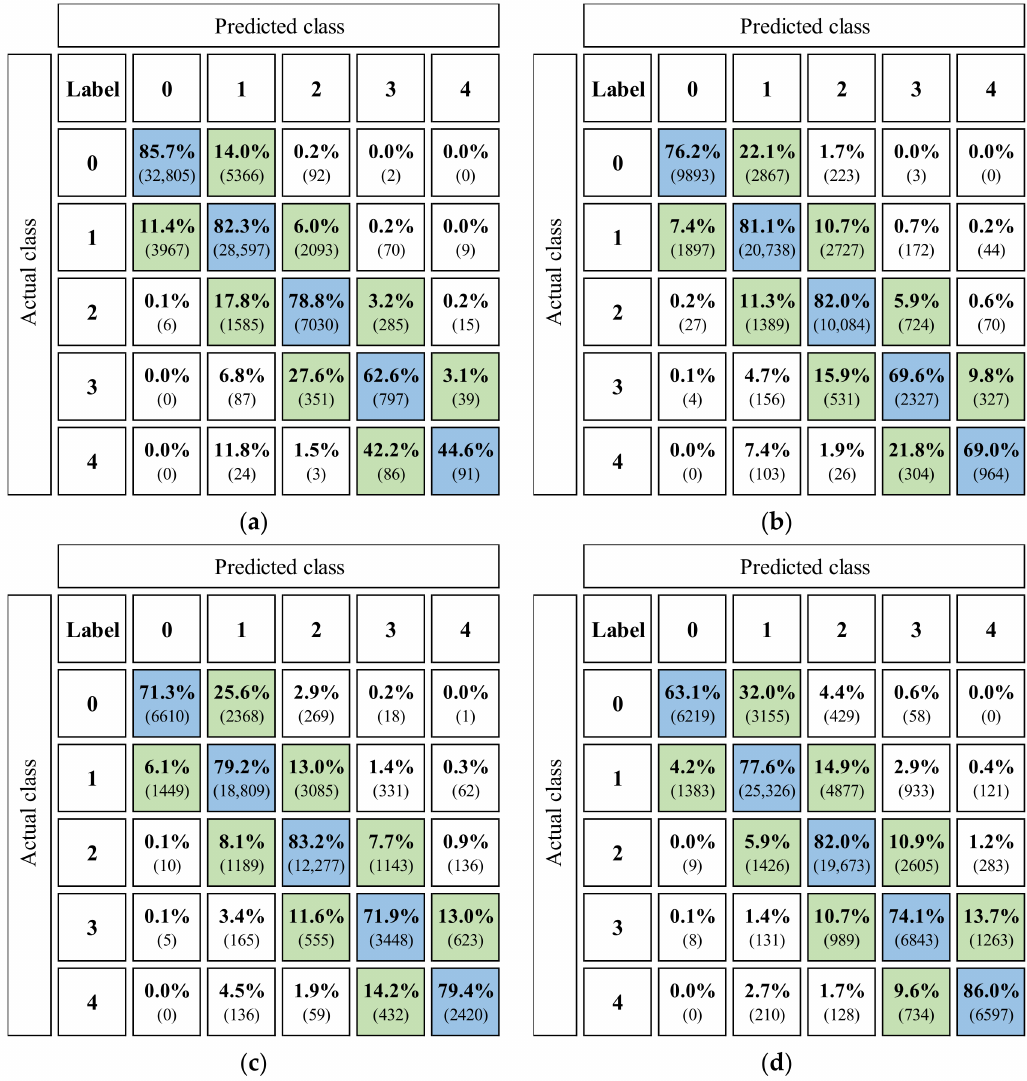
Figure 10. Confusion matrices for buildings with different PGAs: ( a ) PGA of 1–3 m/s 2 (prediction accuracy = 83.1%); ( b ) PGA of 4–5 m/s 2 (prediction accuracy = 79.2%); ( c ) PGA of 6–7 m/s 2 (prediction accuracy = 78.4%); ( d ) PGA of 8–10 m/s 2 (prediction accuracy =